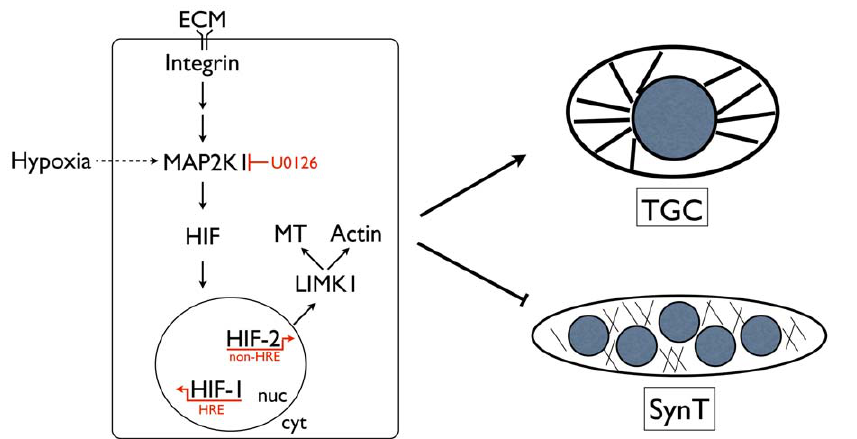
Figure 9. Model of HIF-dependent integration of positional and metabolic cues in the TSC niche. ECM composition regulates HIF stabilization likely downstream of cell surface integrin ligation via MAP2K1/2 activation. Inside-out integrin signaling mechanisms may also be operative. Oxygen sensing and signaling pathways intersect with this signaling cascade to stabilize HIF, when ECM-dependent cues are absent. Stabilized HIF can act via canonical and non-canonical target genes. Non-canonical HIF-2, by interacting with MYC:MAX heterodimers, bind the Limk1 promoter to activate its expression. LIMK1 promotes microtubule and actin stability, critical for TGC formation, and thereby prevents SynT formation. HIF, therefore, can integrate divergent environmental inputs from within the placenta to regulate cell fate via non-canonical gene